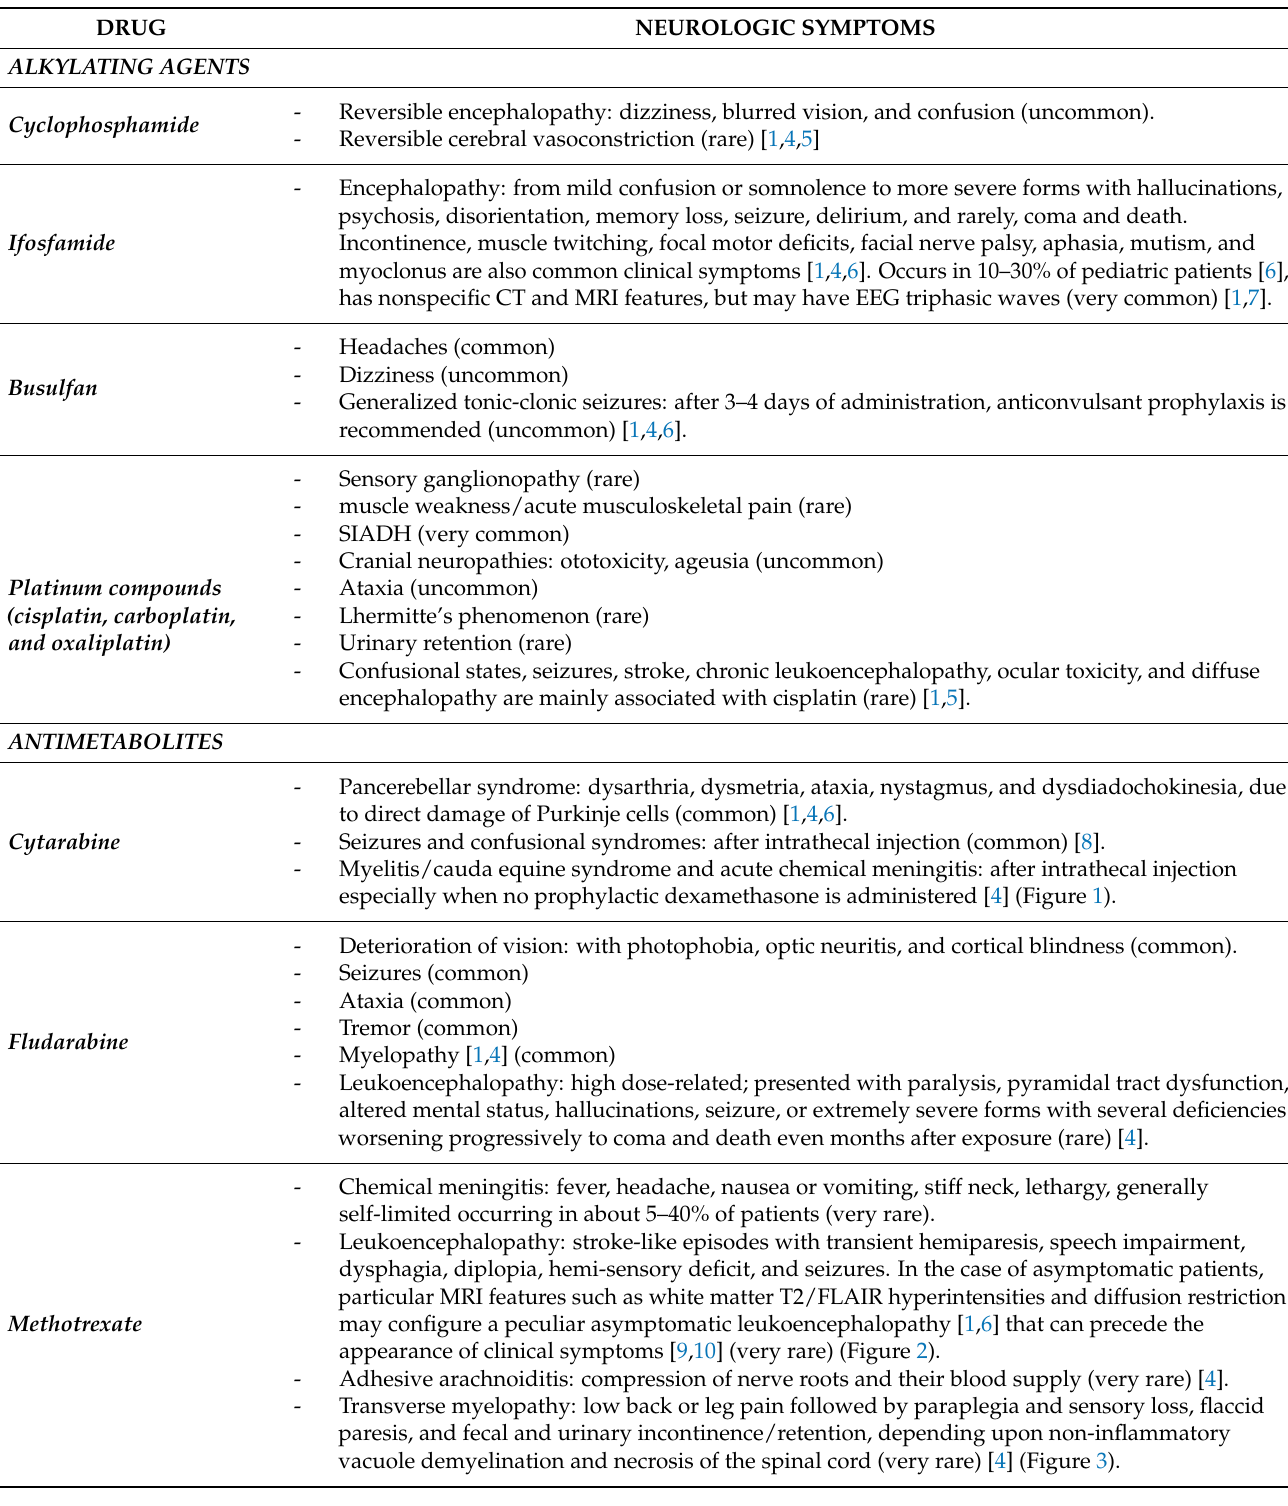
Table 1. Most frequently used chemotherapy drugs in pediatric onco-hematology and their CNS effects